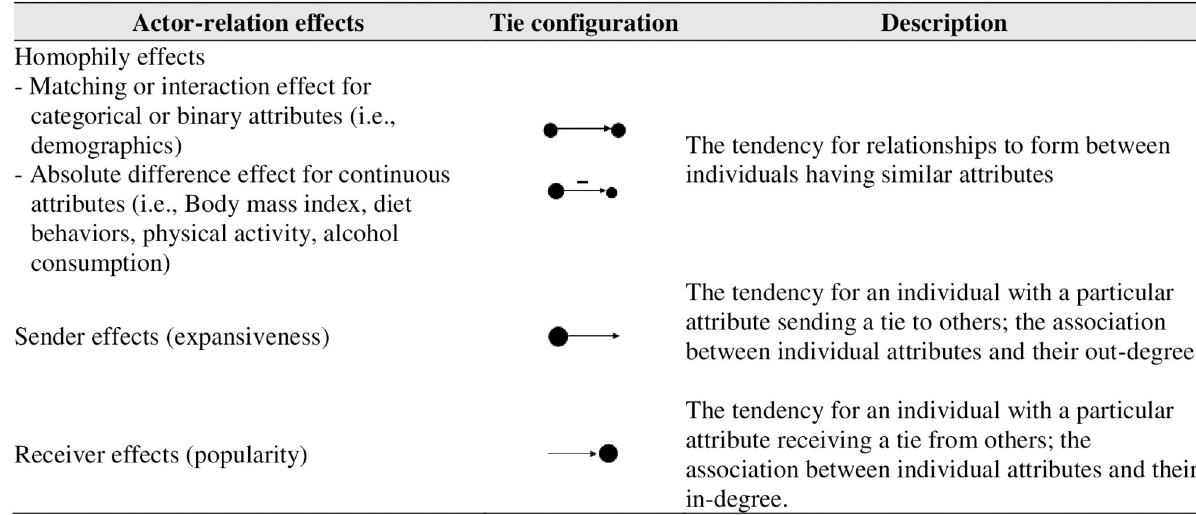
Fig 1. Tie configurations and description of individual-relation effects. Note: Based on Lusher, Koskinen, & Robins [33]; Snijders, Pattison, & Robins [46].